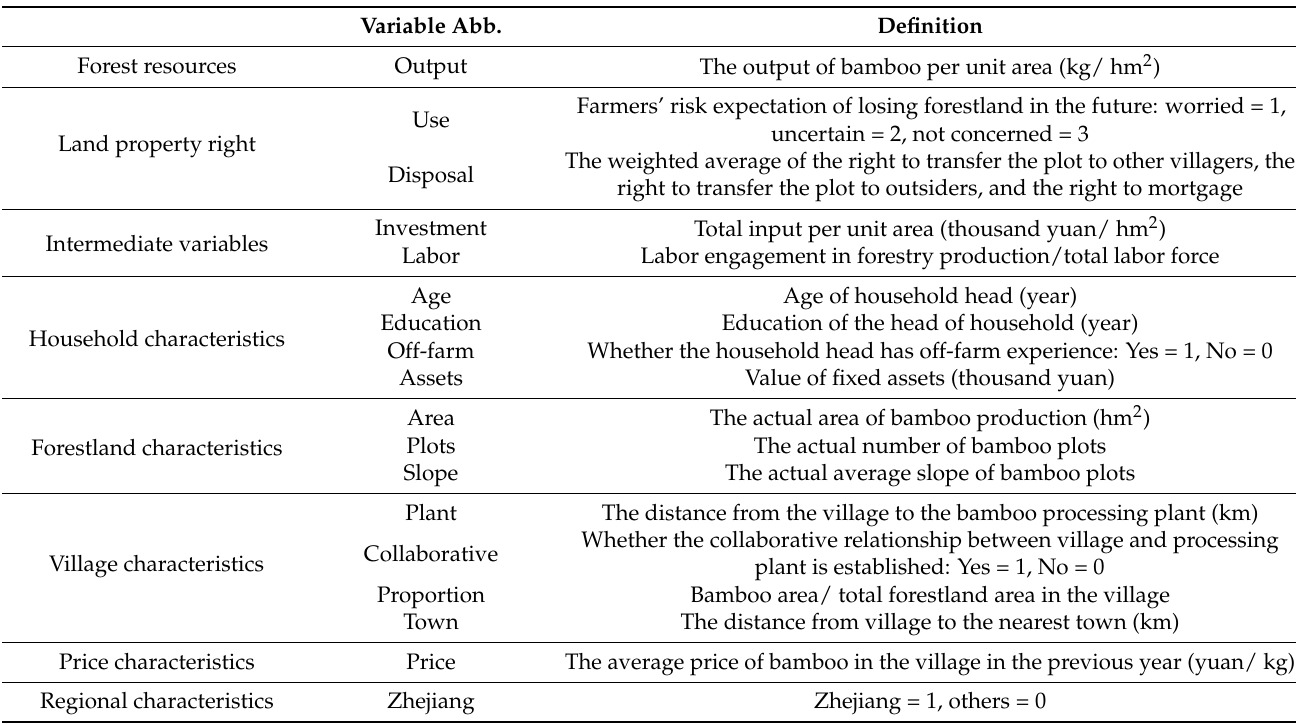
Table 1. Definitions of variables.